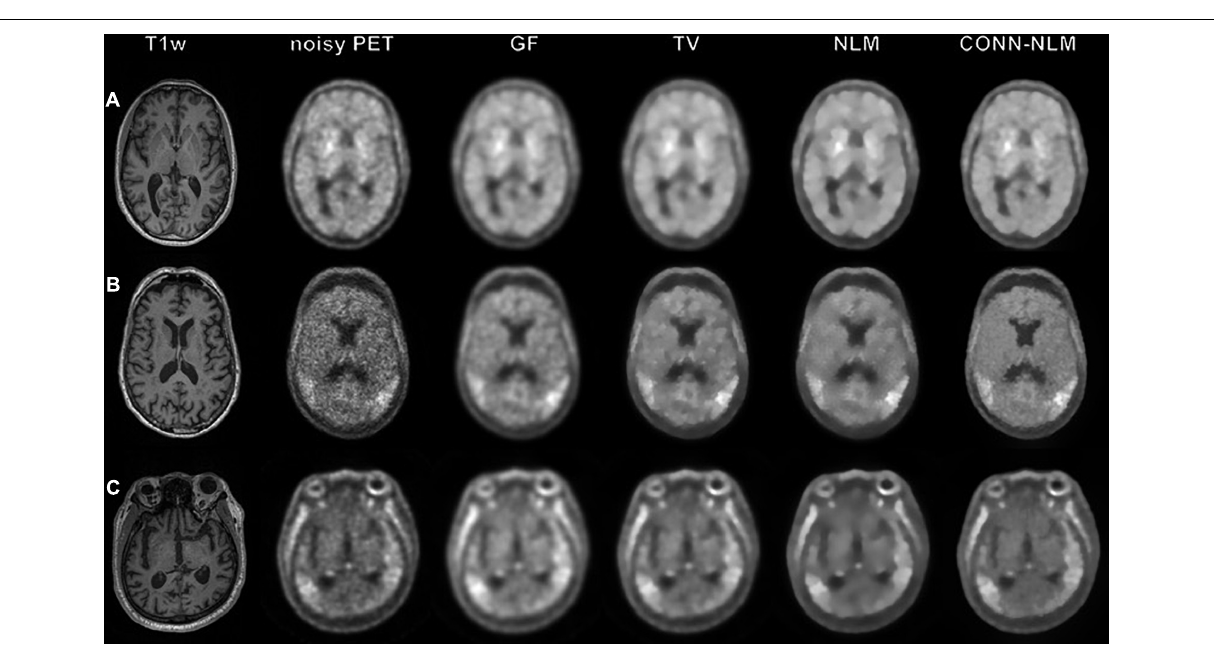
FIGURE 9 | Applying image smoothing on clinical tau-PET and MRI data from (A) a health-control subject (B) a mild cognitive impairment patient and (C) a Alzheimer’s disease patient. From left to right: T1-weighted image, noisy PET image, Gaussian filtering (GF), total variation (TV), nonlocal means (NLM) and the proposed CONN-NLM filtering. Filtering parameters were chosen for all filters to produce approximately the same level of image